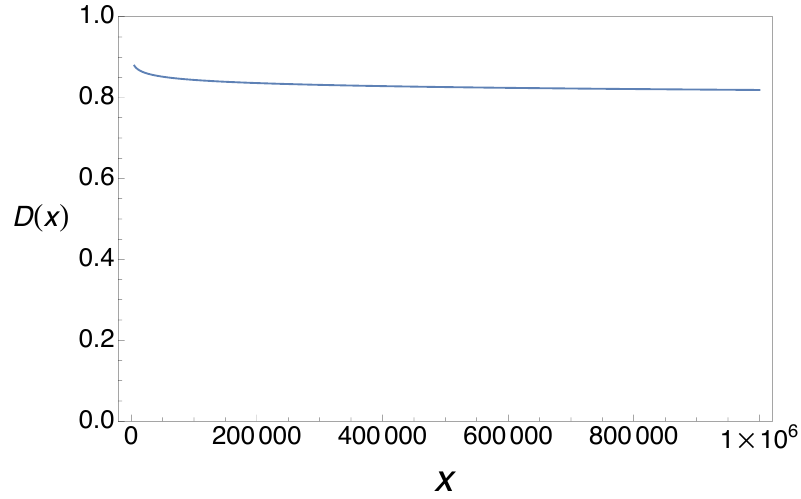
Figure 7. We plot D ( x ) at λ = 1 / 10 and T = 1 / 10 without the non-perturbative branch. Though not as dramatic as figure 6, as one can see D ( x ) still does not go to zero as x → ∞